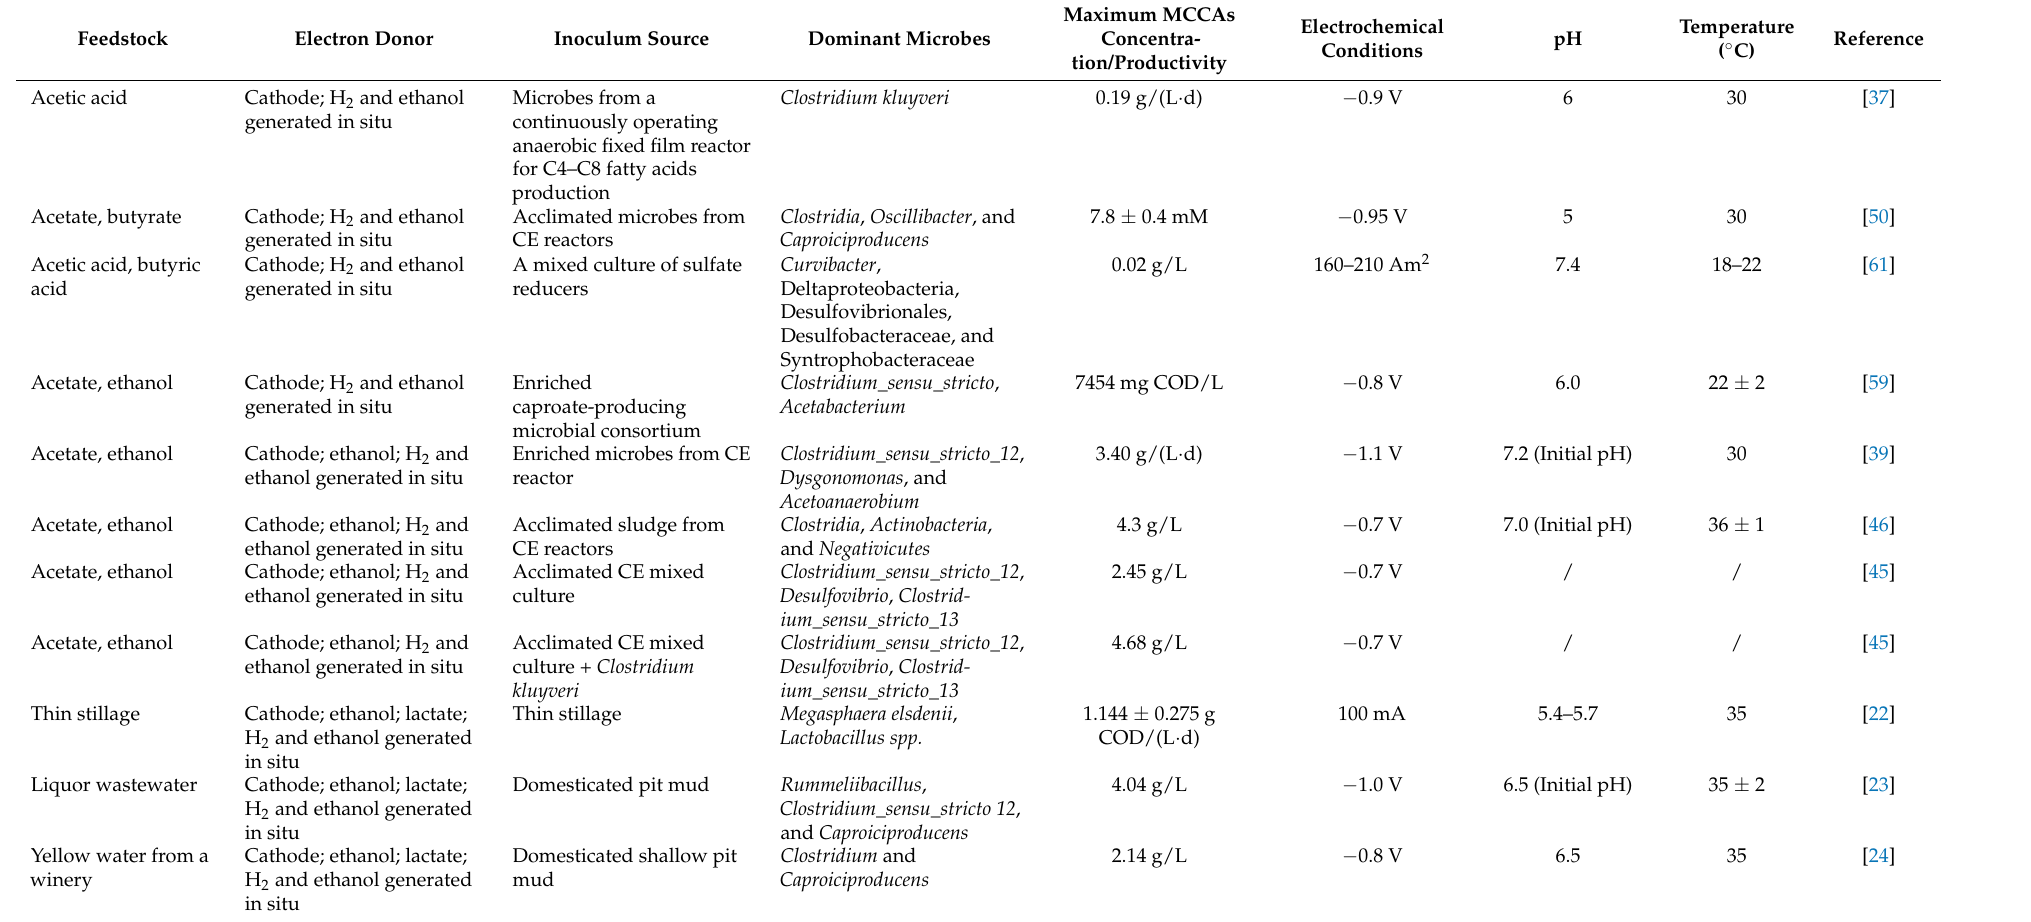
Table 1. Dominant microbes in MCCAs electrofermentation mixed microbial culture